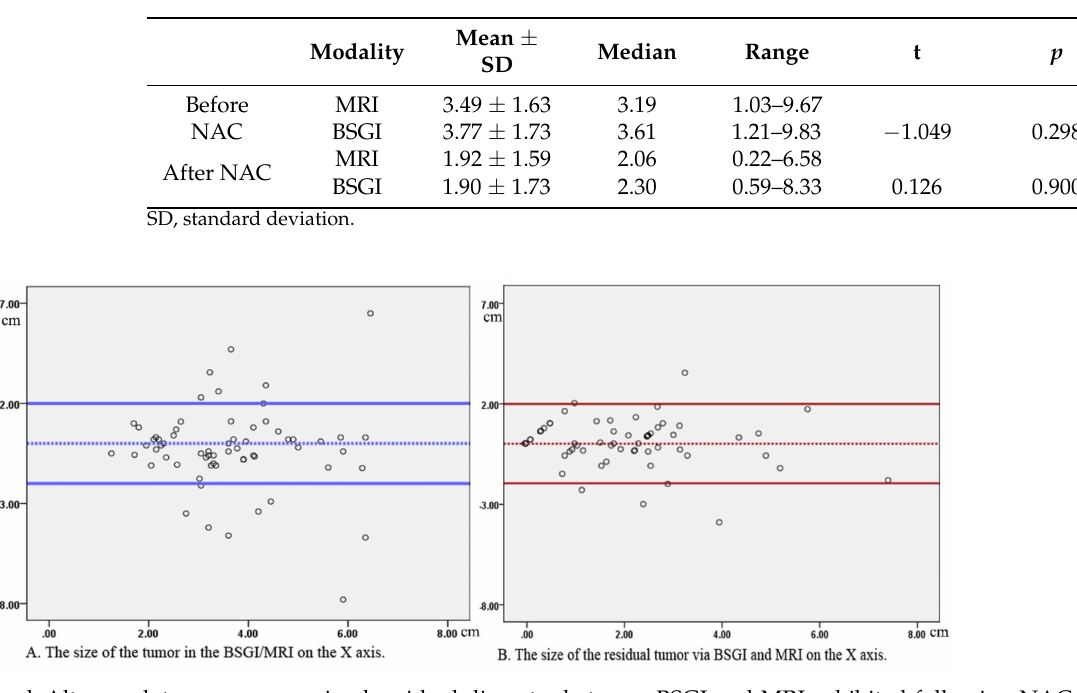
Table 3. The maximal residual diameter between BSGI and MRI exhibited following NAC.